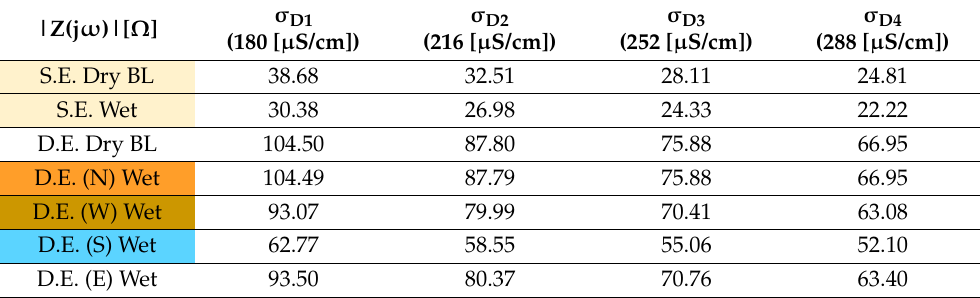
Table 5. Absolute impedances obtained from F.E.M. numerical simulations at 2 MHz for both single- ended (S.E.) and differential-ended (D.E.) biasing schemes as depicted in Figure 17. The latter’s color pattern is followed for the D.E., whereas the S.E. color was added for better readability only. σ |Z(j ω )|[ Ω ]